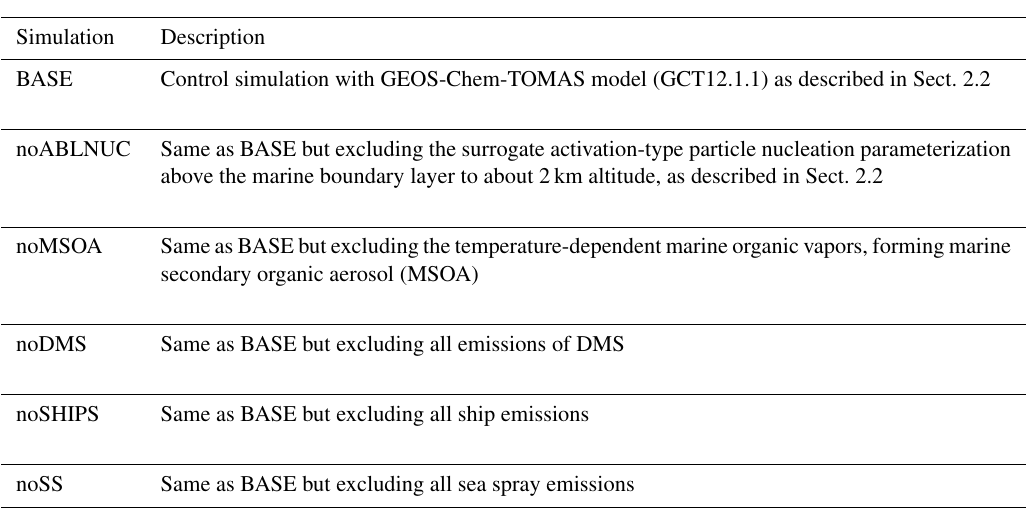
Table 1. GEOS-Chem-TOMAS simulation acronyms. Simulations and methodology are described in detail in Sect. 2.2 and 2.3.